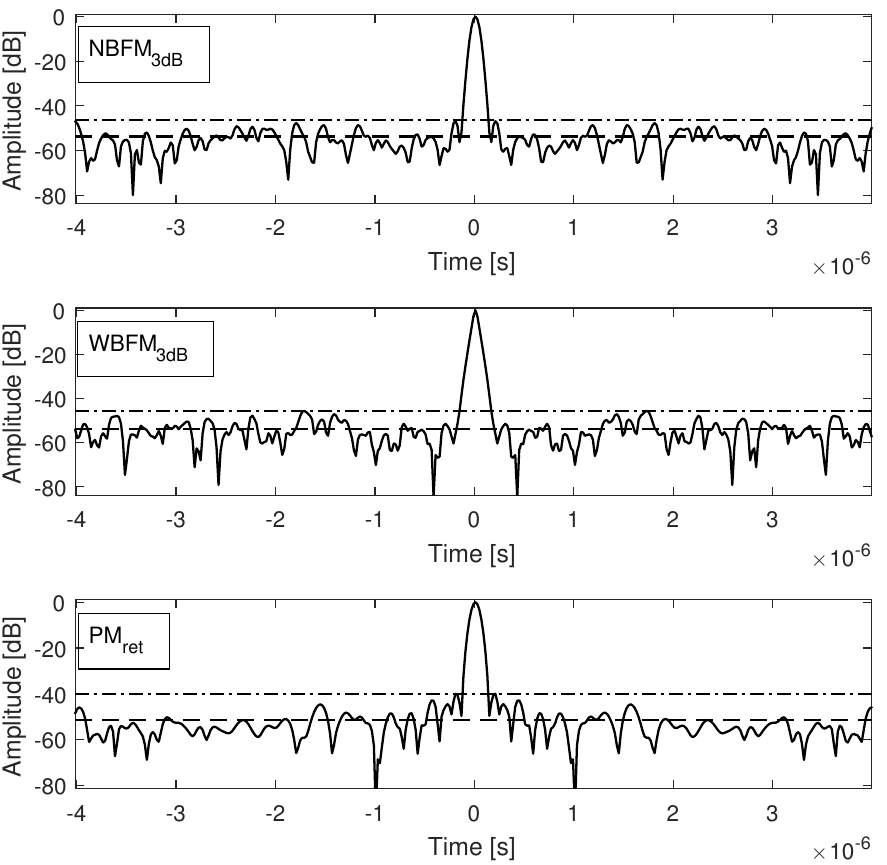
Figure 6. Comparison between matched filter output powers, considering both PM, narrowband, and wideband FM (3 dB Bandwidth) random modulated signals and Gaussian modulating signals with rectangular power spectral density— B ˜ s = 10 MHz, τ s = 10 µ s, n p =